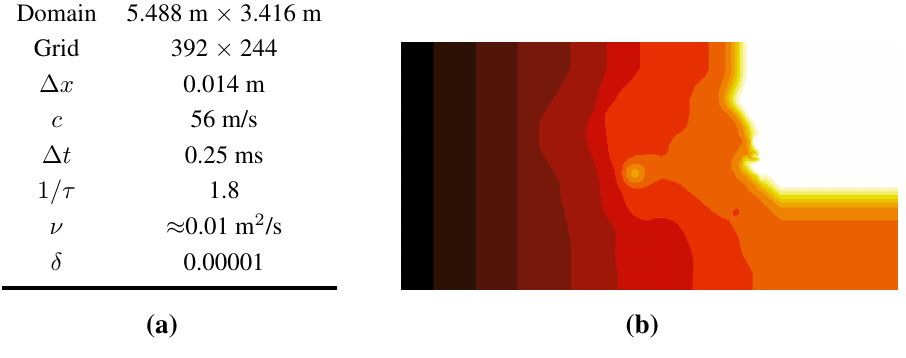
Figure 7. Tsunami runup onto a complex three-dimensional beach. ( a ) Parameters; ( b ) coastal